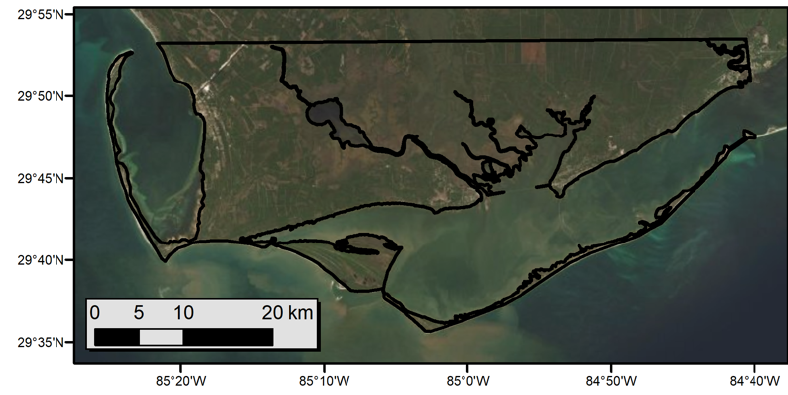
Figure 1. Location map of research setting in Apalachicola Bay, FL.